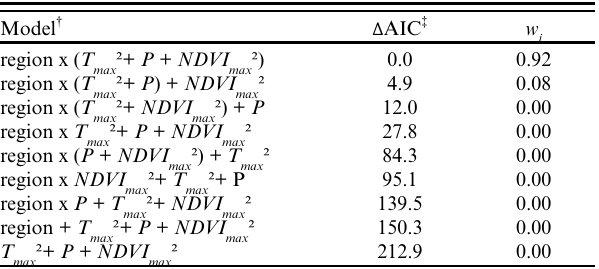
Table 4 . Multimodel comparison of different combinations of models that test for interactions between environmental variables and Sierra Nevadan regions.